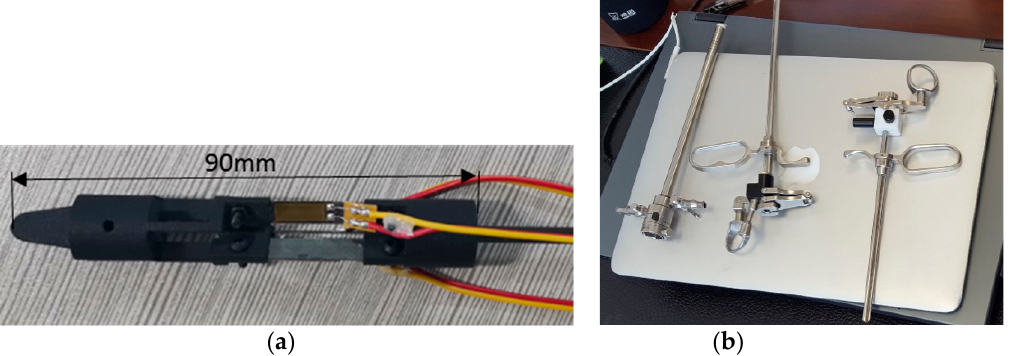
Figure 4. Prototype of the force detection device. ( a ) force detection device to be integrated, ( b ) surgical instrument in